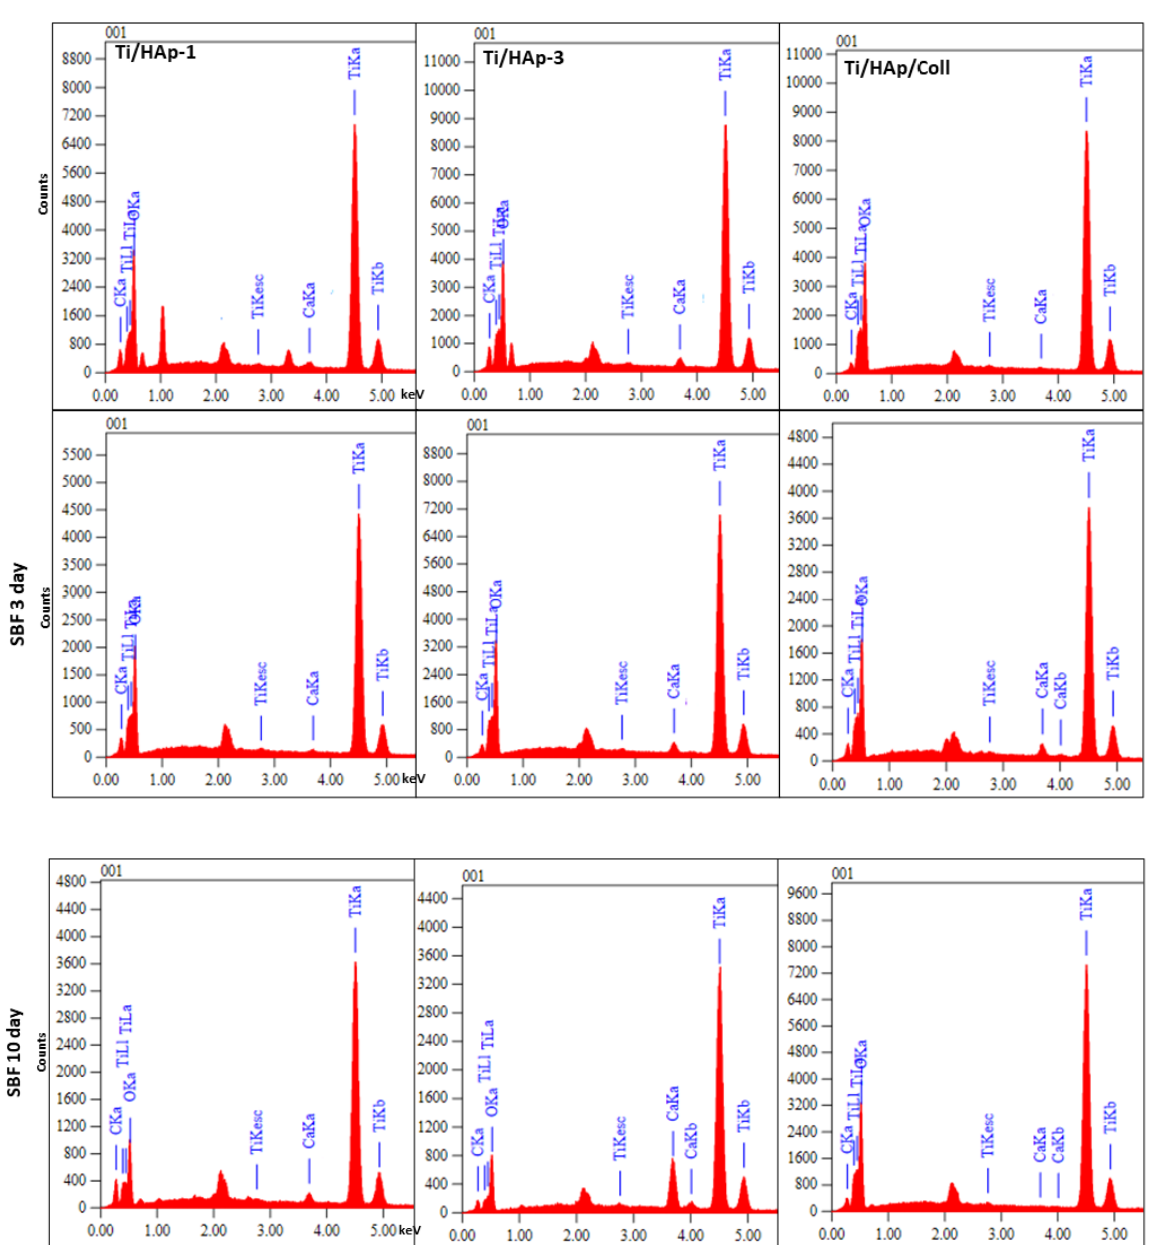
Figure 8. The EDS spectrum of Ti/HAp-1, Ti/HAp-3, and Ti/HAp-coll before SBF and after SBF immersion.